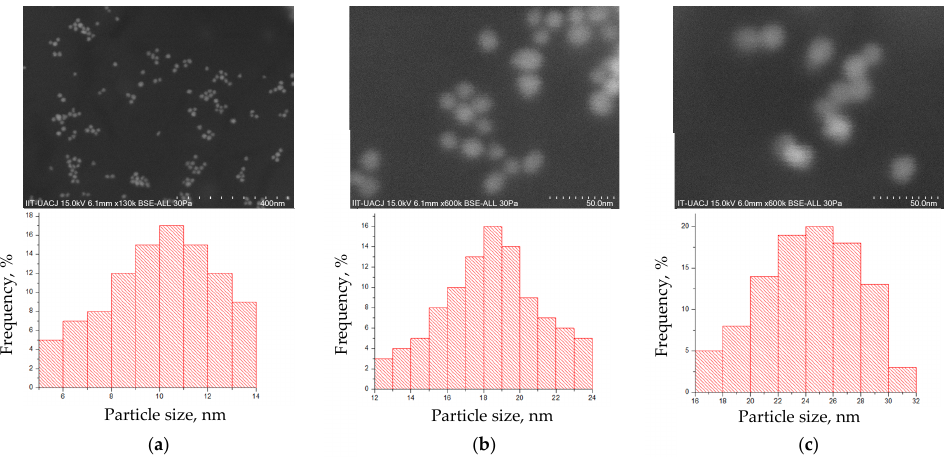
Figure 1. SEM images of the AuNP particles. In panel ( a ), the AuNPs are shown without any coating. In panel ( b ), the AuNPs are coated with PEG, which can be observed to slightly increase the size of the particles and maintain their dispersion. In panel ( c ), the AuNPs are coated with silica, which can be seen to form small aggregates on the surface of the particles. All the particles shown in the figure are spherical in shape.